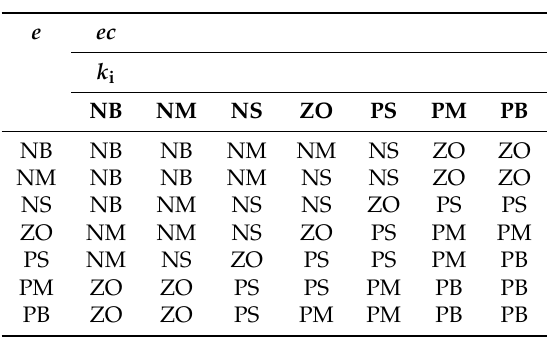
Table 4. Fuzzy rule k i .